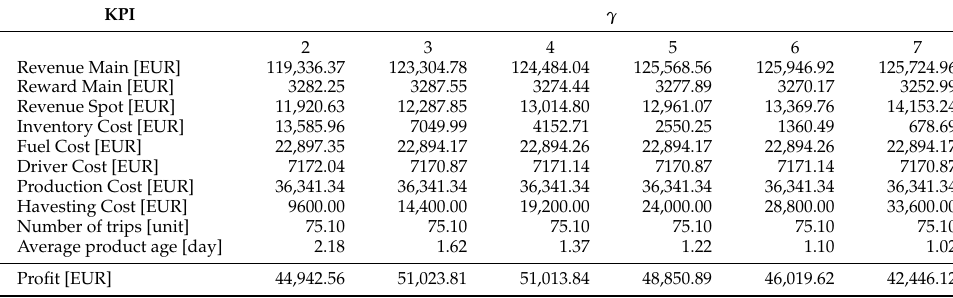
Table 9. Average KPIs for the case of θ = 9 h (company C 1